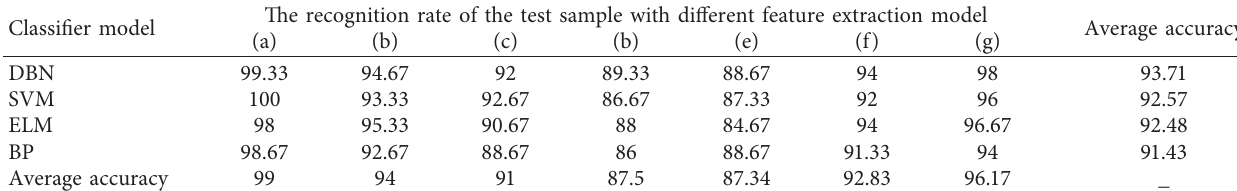
Table 6: The recognition results of seven models with four recognizers (%). Classifier